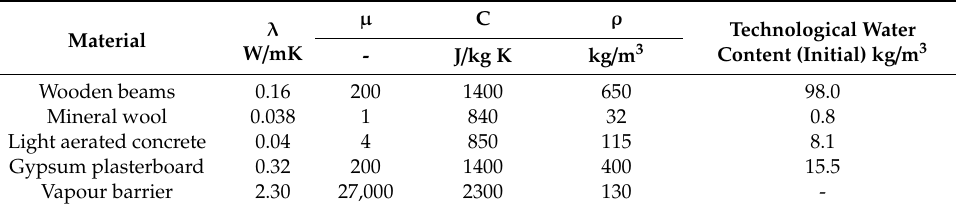
Table 5. Listing of data assumed for